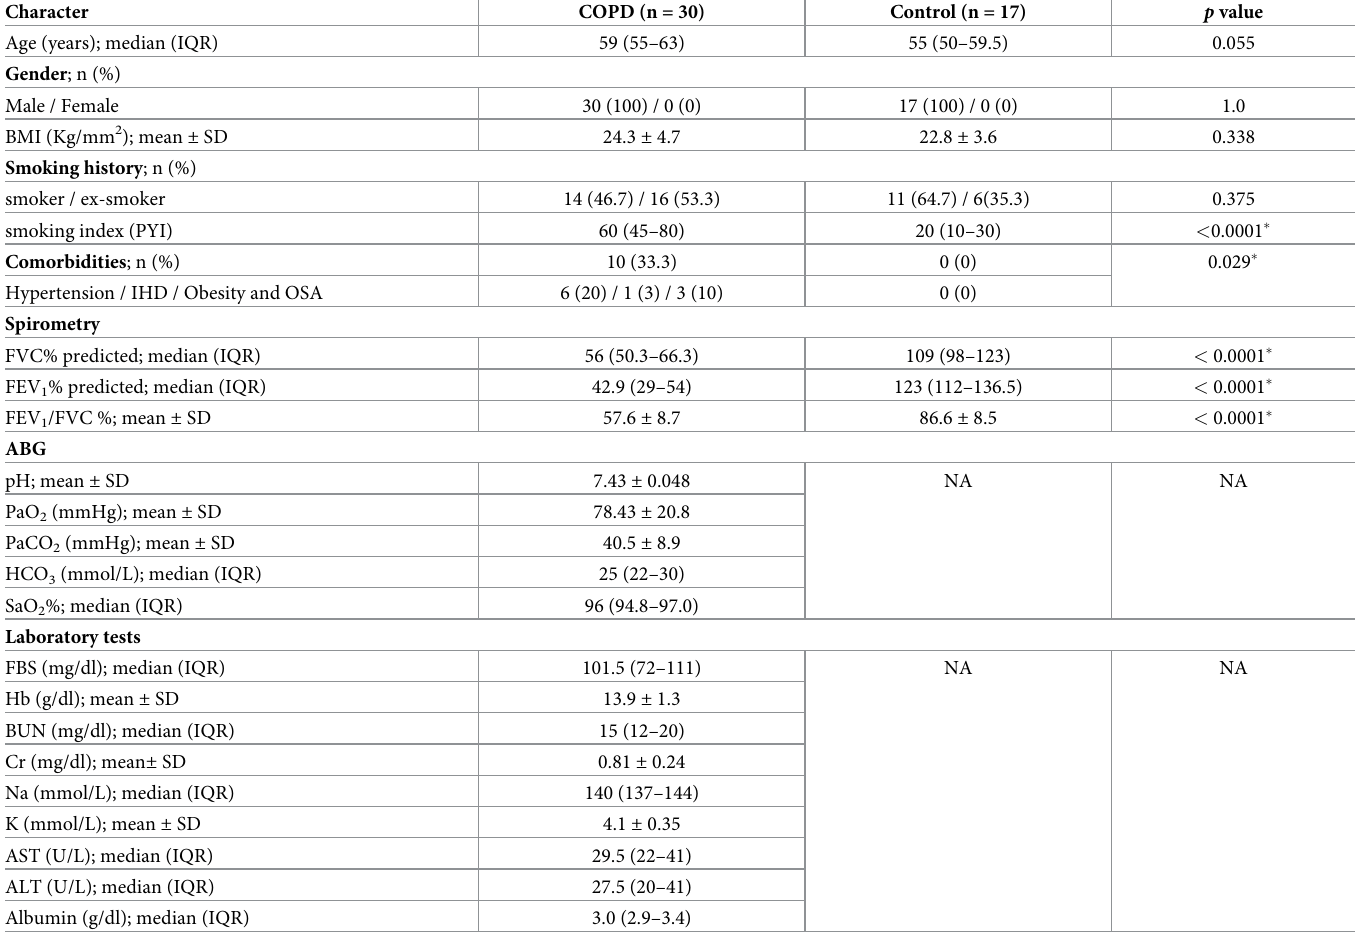
Table 1. Demographic and baseline clinical characteristics of study